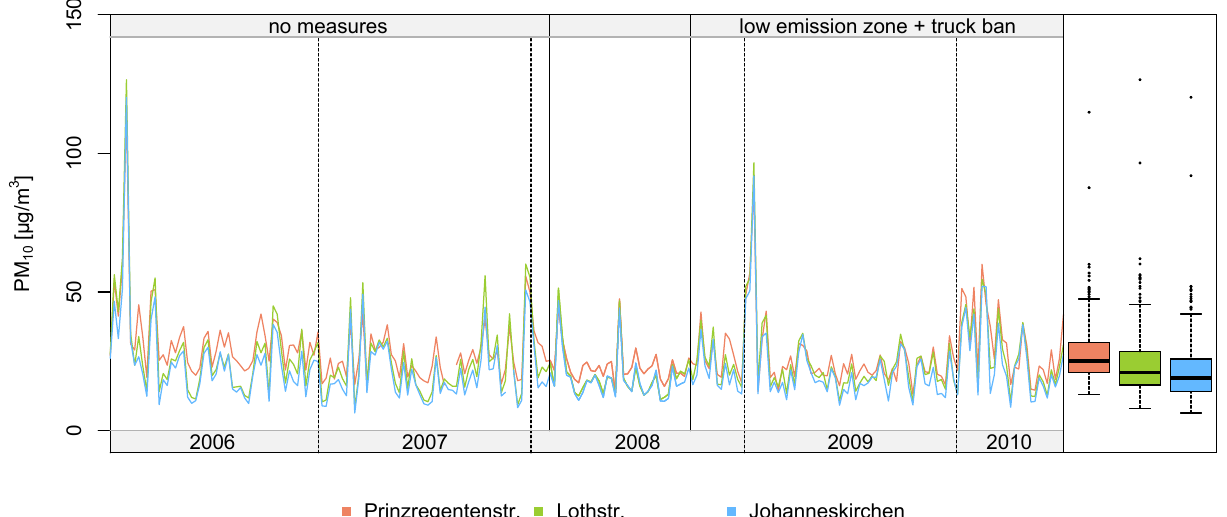
Figure 2. Time series of weekly averages of PM in Munich, Germany (Prinzregentenstrasse, Lothstrasse, and Johanneskirchen). The three boxplots (on the right-hand side) describe the respective distributions the PM concentrations at the three sites ignoring the temporal